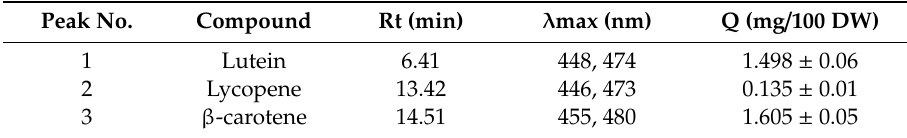
Table 1. Identification and quantification of carotenoids in TP.